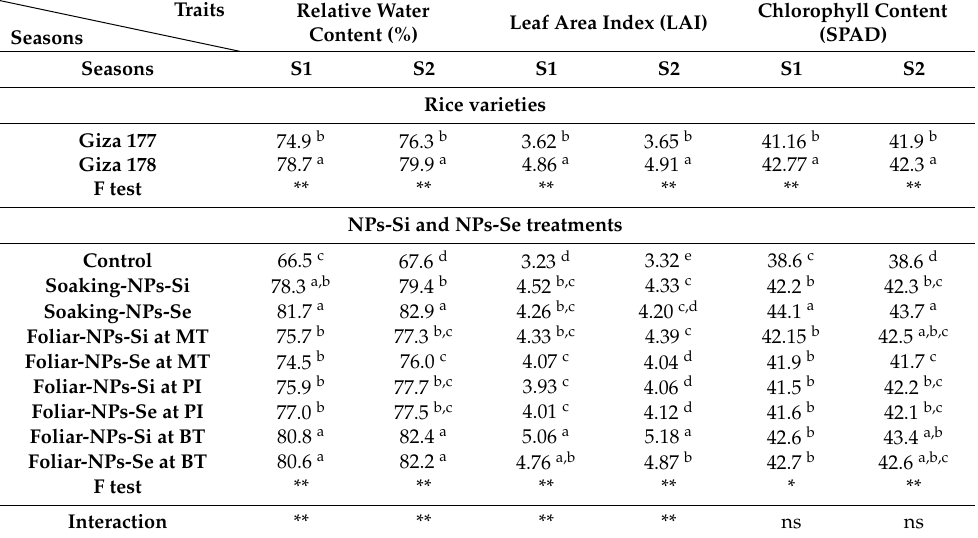
Table 4. Effect of NPs-Si and NPs-Se treatments on relative water content, leaf area index, and chlorophyll content of two rice varieties under saline soil conditions in the 2018 (S1) and 2019 (S2)